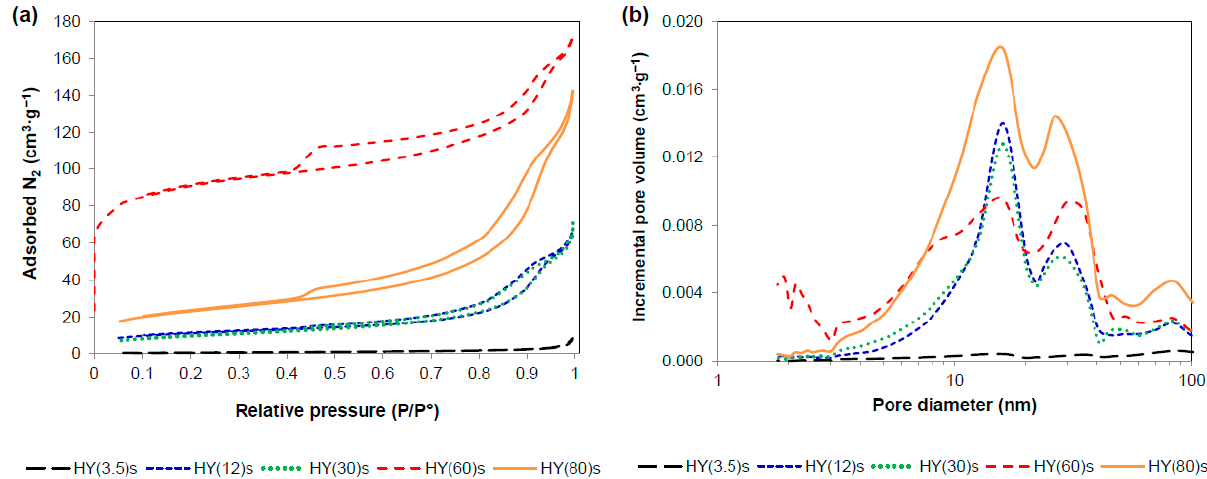
Figure 11. ( a ) N 2 adsorption-desorption isotherms and ( b ) pore size distribution of the spent zeolites.